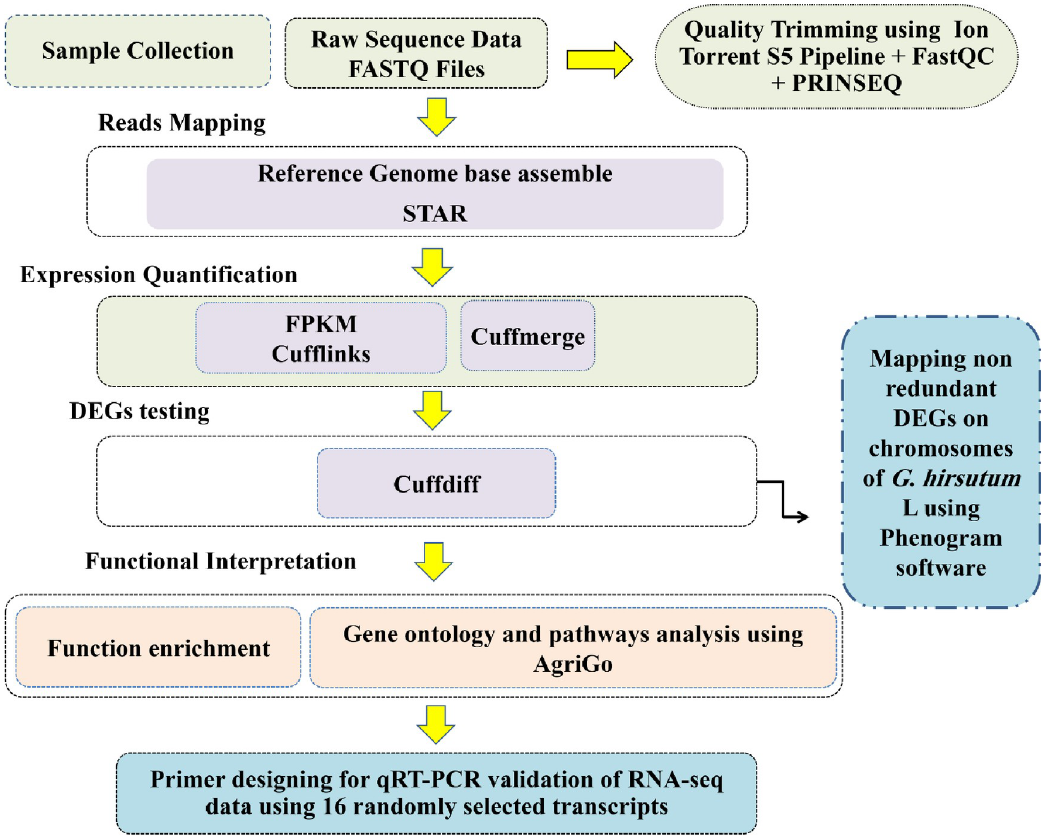
Fig 1. A detailed workflow performed in identification of DEGs in CGMS, maintainer and restorer lines of Gossypium hirsutum